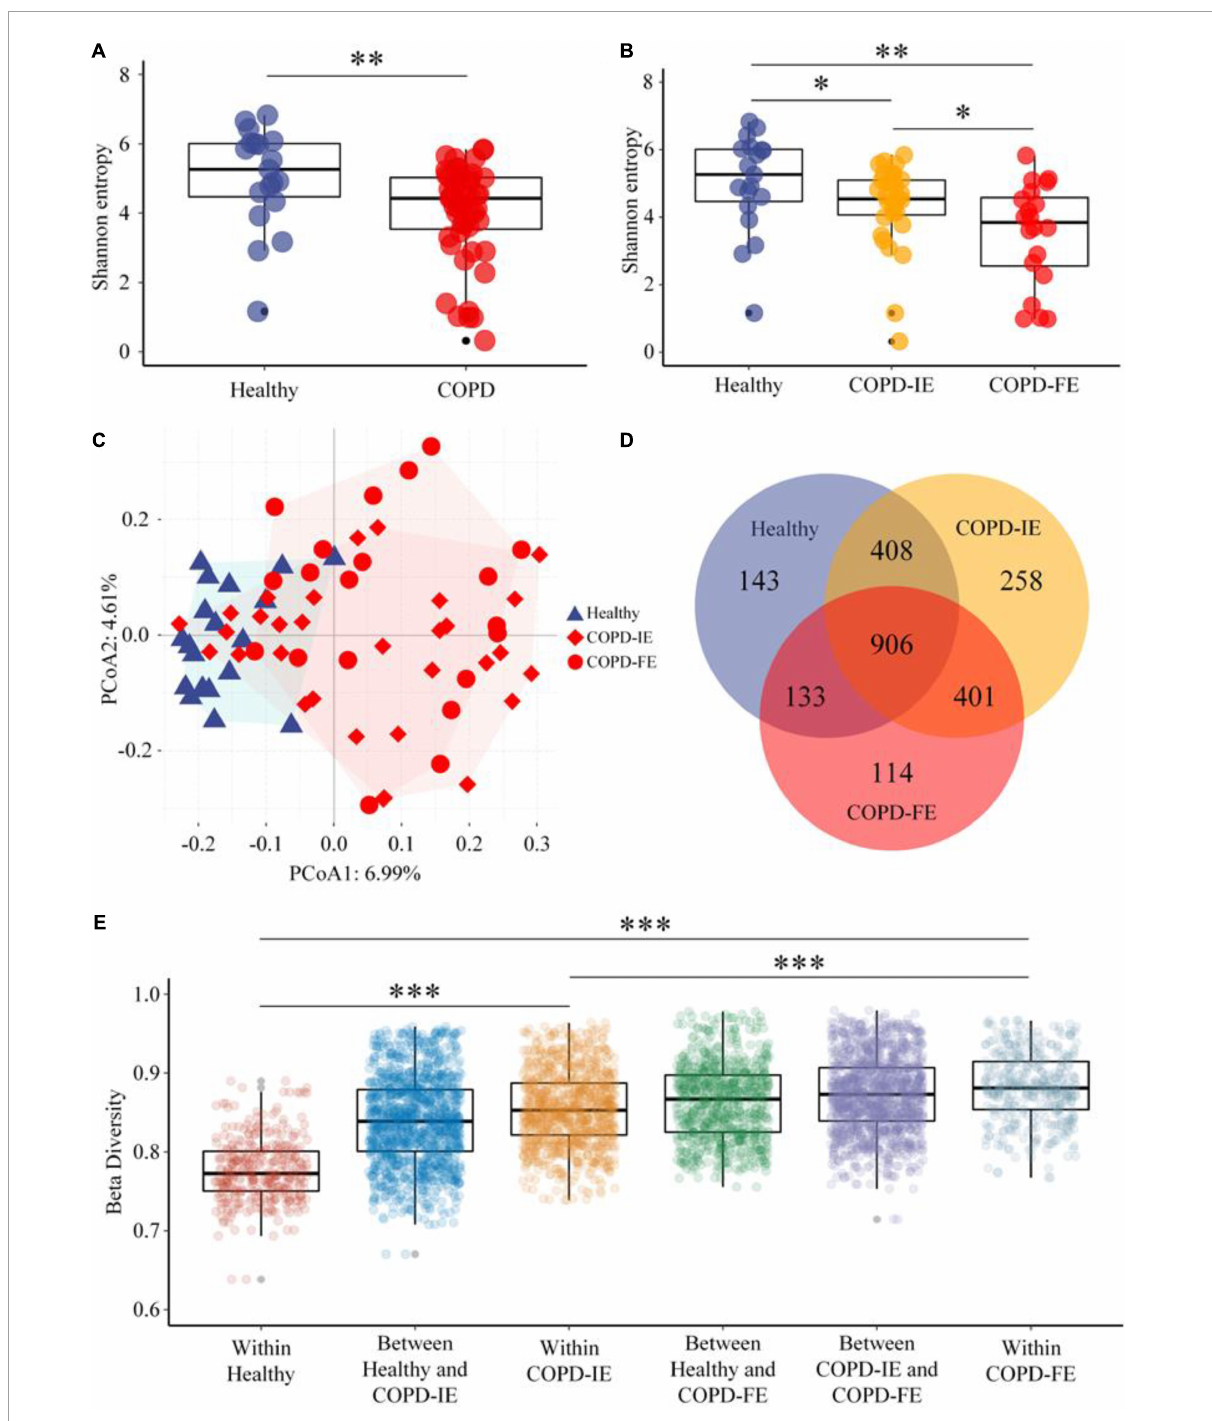
FIGURE3 Sputum microbiome diversity analysis. (A) As estimated by Shannon entropy, sputum microbial diversity was significantly decreased in chronic obstructive pulmonary disease (COPD) ( n = 51) compared with that in the healthy controls ( n = 19). (B) Shannon entropy of COPD-IE and COPD-FE group in comparison with healthy controls. (C) PCoA analysis based on amplicon sequence variants (ASVs) features distribution showed that healthy subjects form a distinguishable cluster differing from COPD groups while a large overlap of clustering was detected between frequent and infrequent exacerbation phenotypes. (D) Venn diagram displaying the overlaps between groups. (E) Beta diversity analysis based on the Jaccard distance and Wilcoxon test demonstrated that besides the expected significant differences between the healthy control group and COPD sub-cohorts (COPD-IE and COPD-FE), the distinction between COPD-IE and COPD-FE was also statistically significant. ∗ p < 0.05; ∗∗ p < 0.01; ∗∗∗ p <